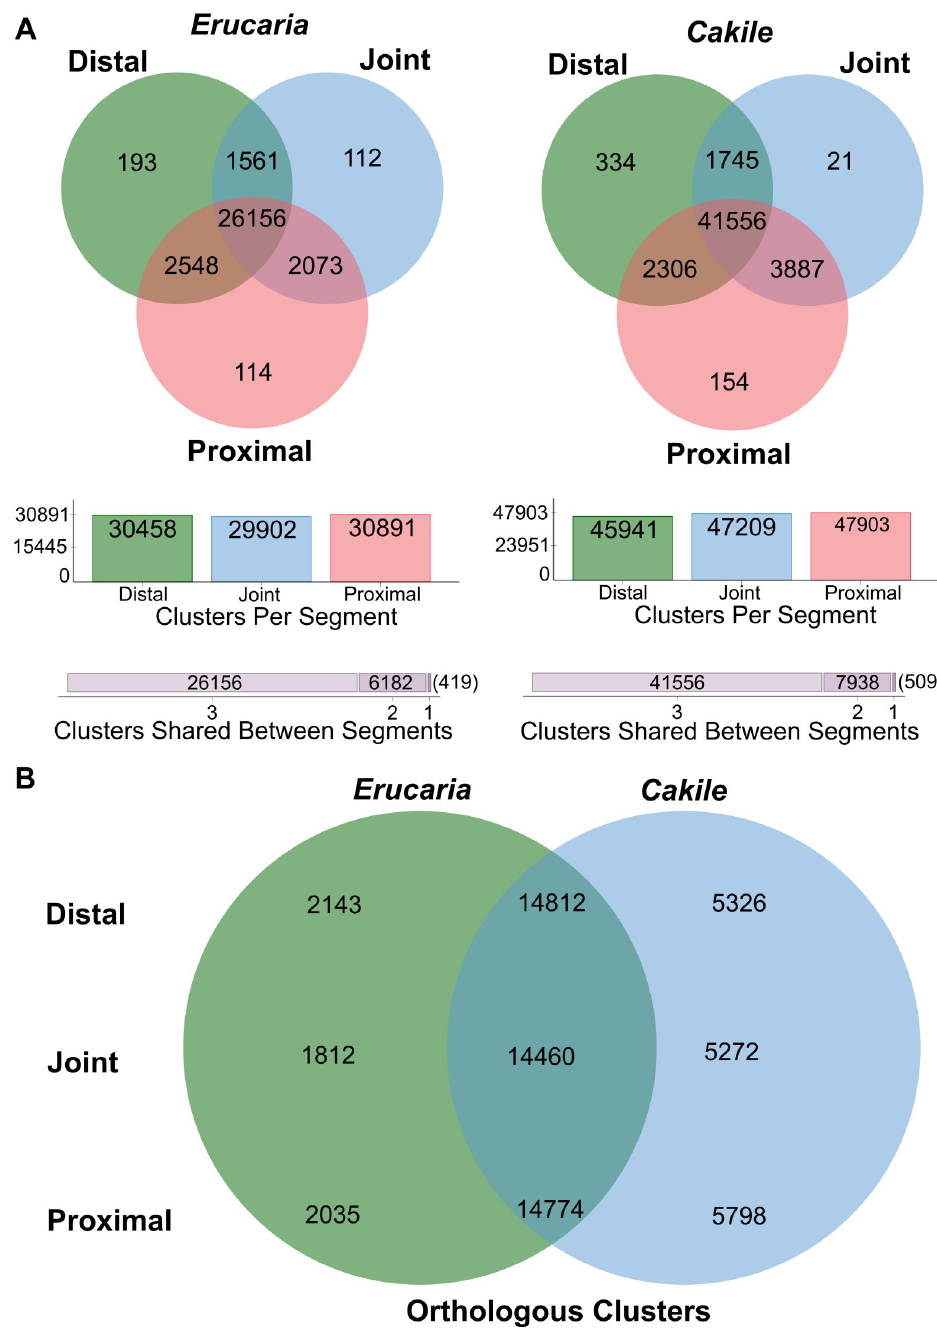
Fig 4. Venn diagrams of three-way and pairwise High Throughput Sequencing (HTS) filtered transcripts for Erucaria erucarioides and Cakile lanceolata transcriptomes. (A), Three-way Venn diagrams of Erucaria and Cakile orthologous clusters for distal, joint, and proximal regions. (B), Pairwise Venn diagrams of Erucaria and Cakile orthologue-clustered transcripts ( Erucaria region vs Cakile